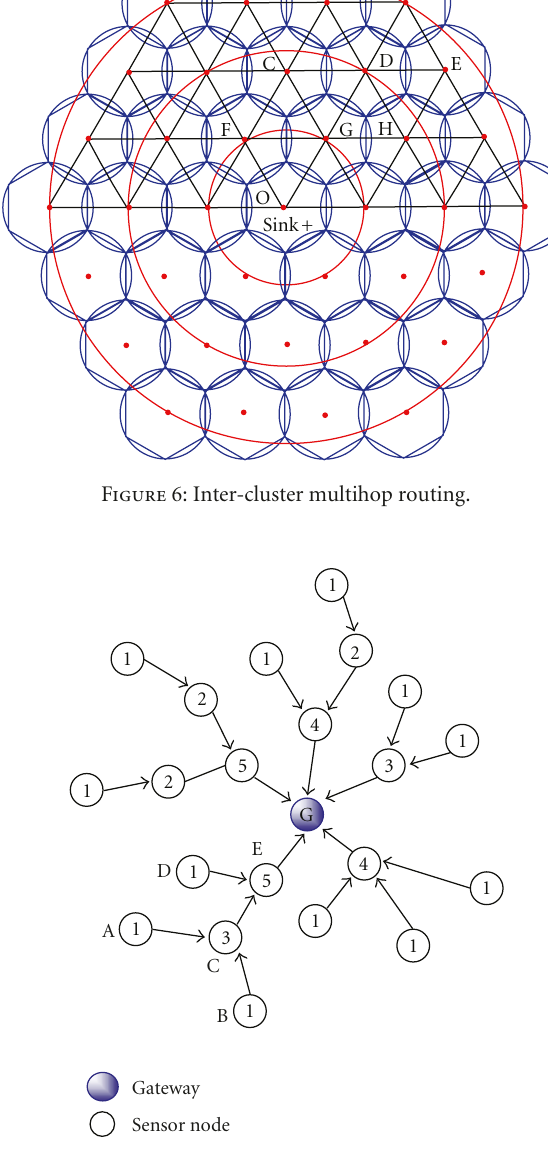
Figure 7: Intra-cluster time-slot distribution of